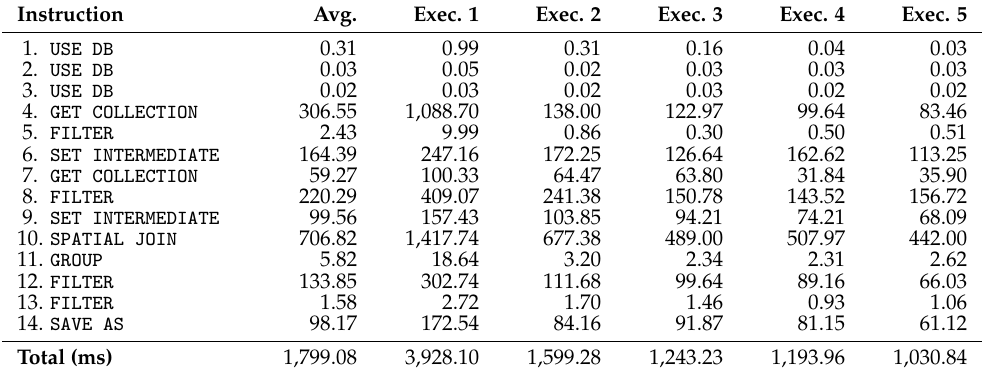
Table 3. Execution times (in ms) for data set DS_1 on one single process of the J-CO-QL Engine .